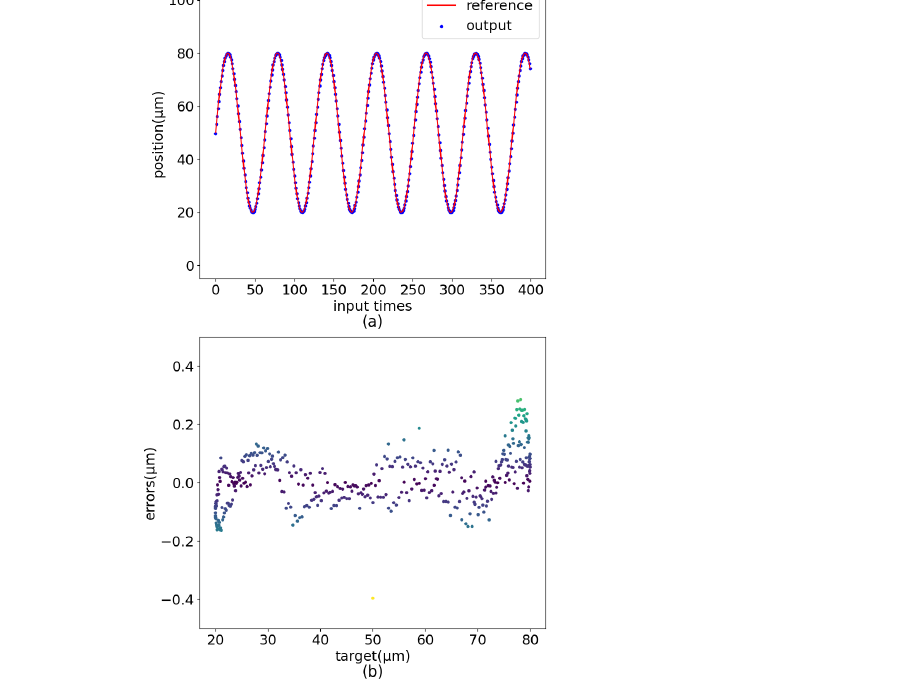
Figure 16. Sinusoidal motion control renderings. ( a ) Curve comparision. ( b ) Error distribution.